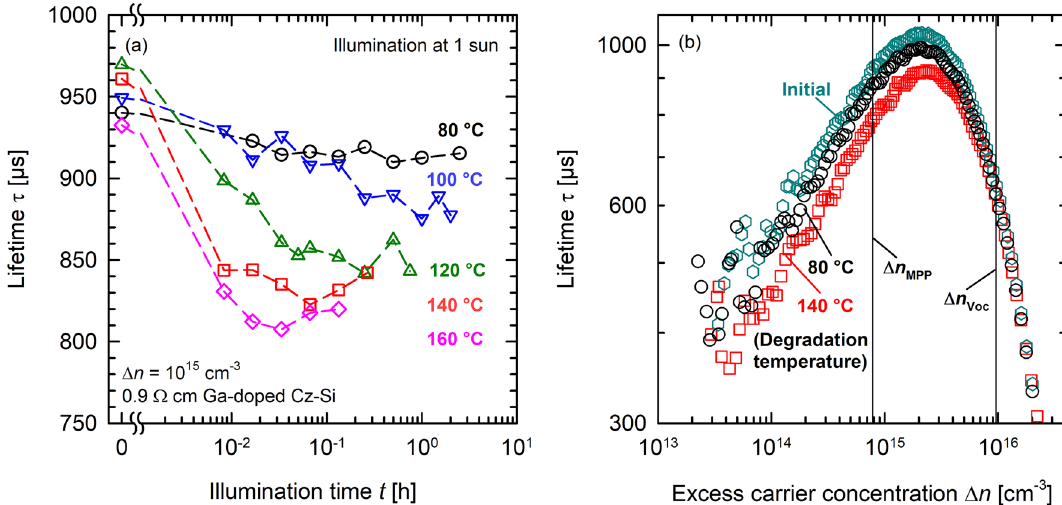
Figure 5. Lifetime degradation of a Ga-doped Cz-Si sample (cell without metallisation) during one-sun illumination. Shown is ( a ) the lifetime degradation at temperatures ranging from 80 to 160 °C at one-sun illumination and ( b ) the injection-dependent lifetimes before degradation (initial, cyan hexagons) and after degradation for 30 min at 80 °C (black circles) and 4 min at 140 °C (red